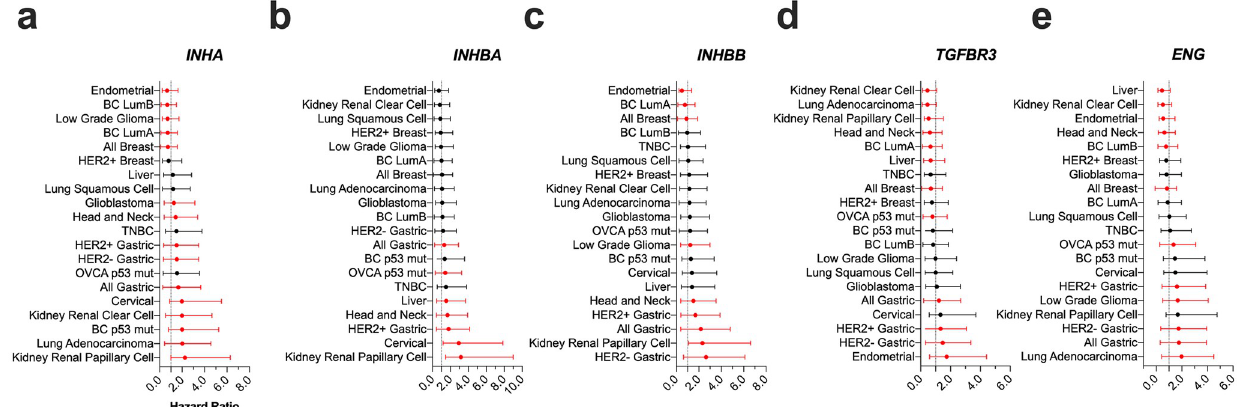
Fig 2. Impact of INHA , INHBA , INHBB , TGFBR3 , and ENG on patient survival in indicated cancers. (a) Forest Plot with Hazard Ratios (HR) of indicated genes generated from KM Plotter or data from cBioportal. Black dots represent HR that are not statistically significant (p > 0.05) and red dots represent HR that are statistically significant (p < 0.05). All numeric data are available in S2 Table.